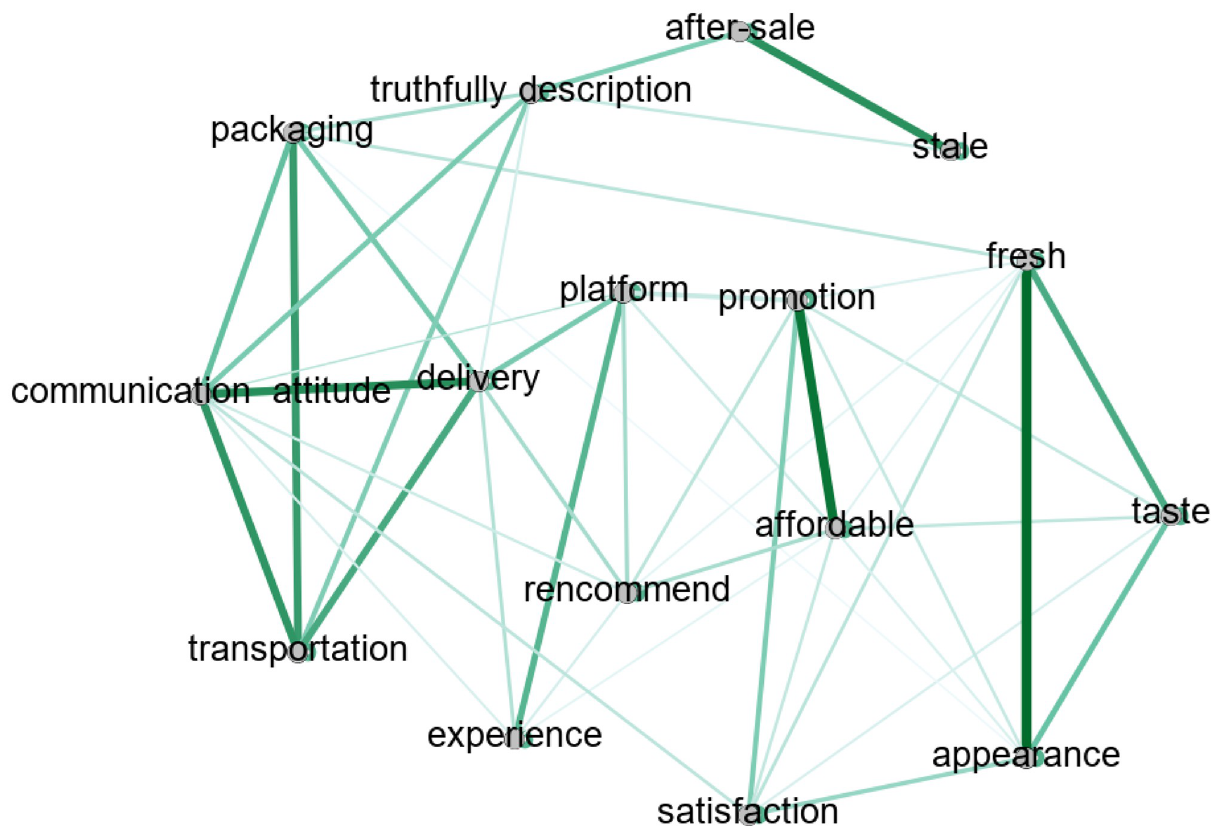
Fig 4. Network of topic